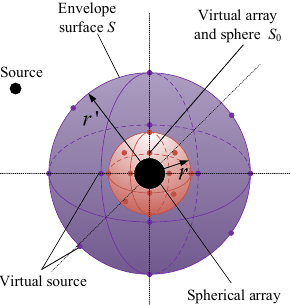
Figure 1. Schematic diagram of virtual spherical array